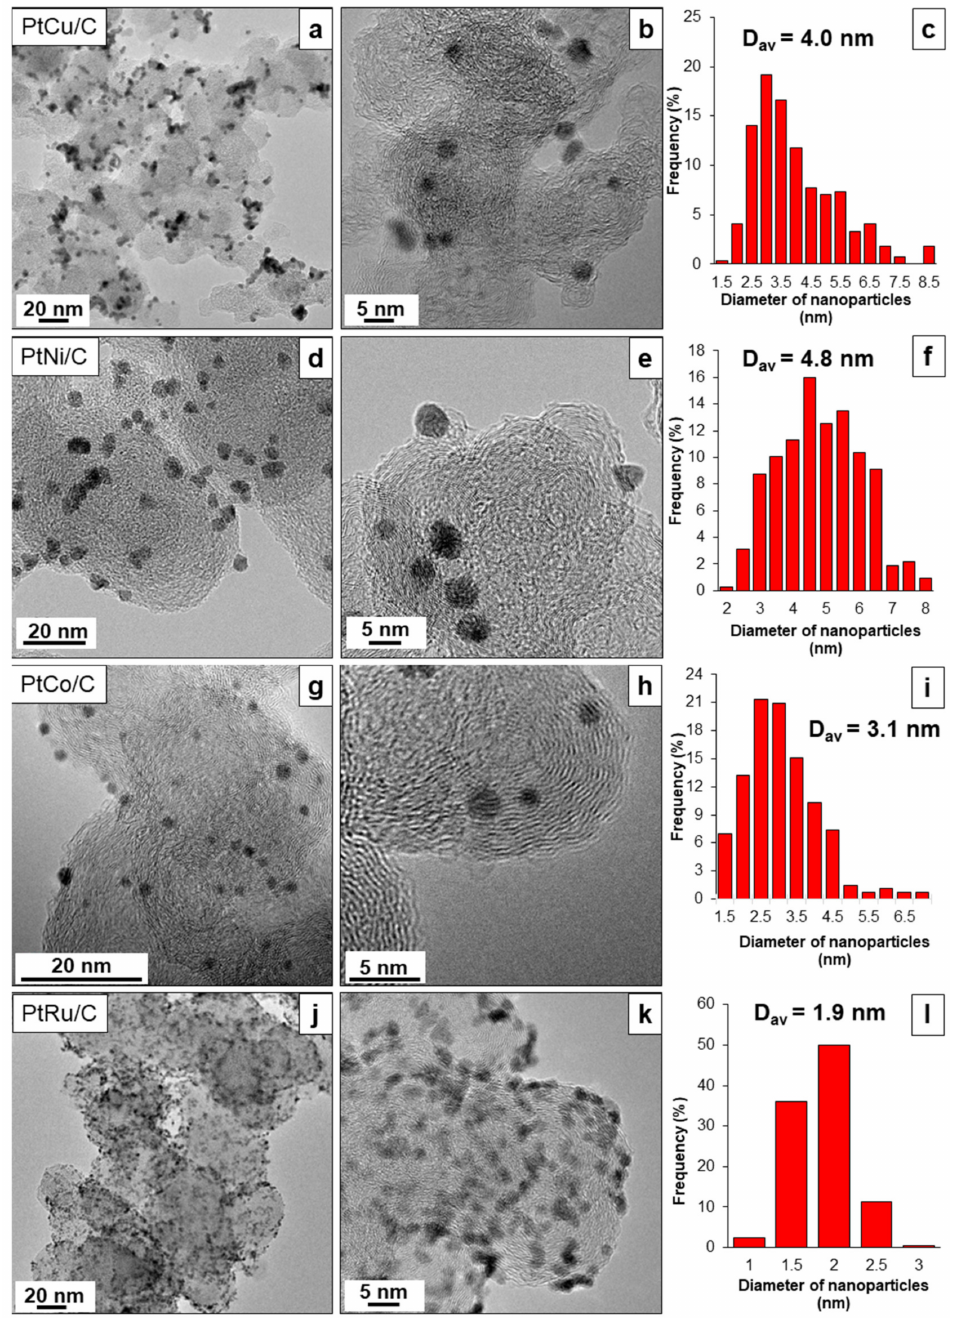
Figure 2. The TEM micrographs of the PtM/C samples: PtCu/C ( a , b ), PtNi/C ( d , e ), PtCo/C ( g , h ), PtRu/C ( j , k ); the histograms of the NPs’ size distribution ( c , f , i , l ) in the corresponding